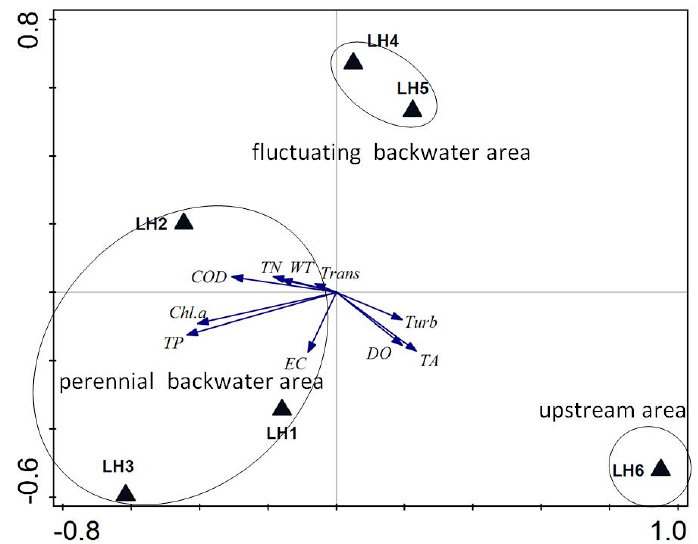
Figure 10. RDA ordination biplot of environmental variables and time succession from the LR, China, 2013–2015.